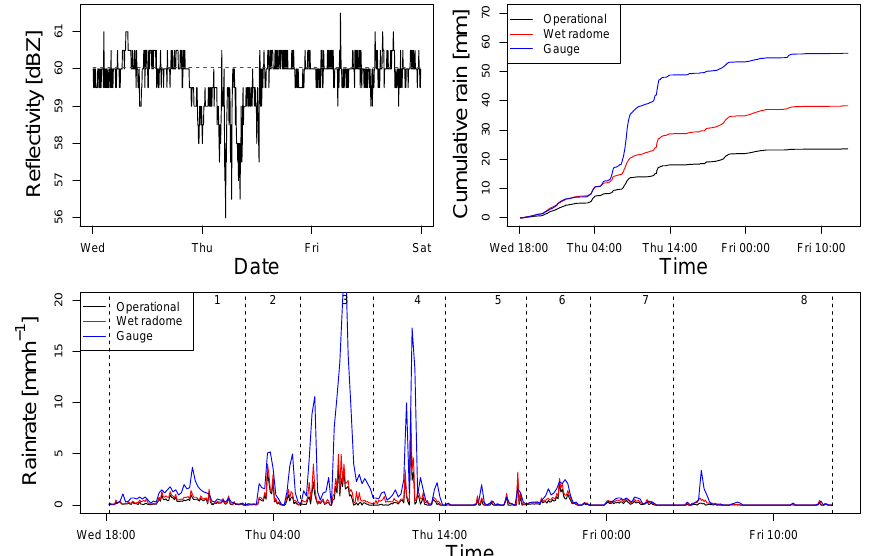
Figure 7. Top-left panel: reflectivity of a strongly reflective clutter pixel near the radar. Here the red dashed line is the average reflectivity when there is no rain. Top right panel: the cumulative rain for the rain gauge (blue), the Doppler clutter-corrected (black) and the wet-radome- attenuation-corrected rain rate using the Marshall–Palmer Z – R relation using the static-clutter- and calibration-corrected data (red). Bottom panel: time series of the rain gauge, KNMI (Doppler filter) clutter-corrected and the wet-radome-attenuation-corrected rain rates.